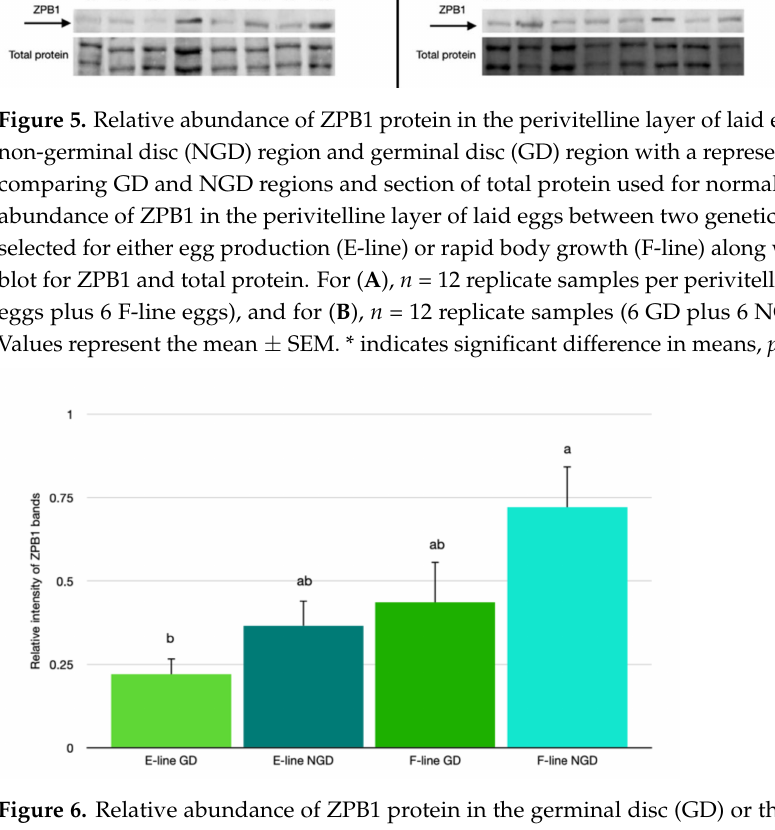
Figure 6. Relative abundance of ZPB1 protein in the germinal disc (GD) or the non-germinal disc (NGD) region of the perivitelline layer from two genetic lines of turkeys selected for egg production (E-line) or rapid body growth (F-line). Values represent the mean ± SEM. n = 6 replicate samples. Means with different letters differ, p <